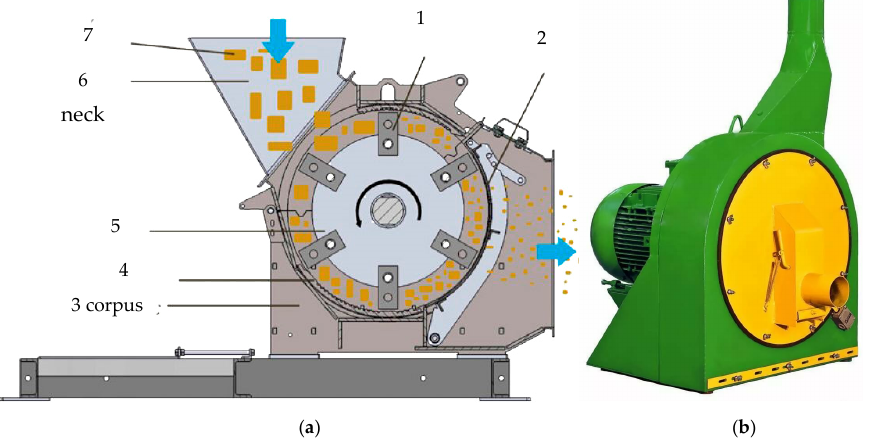
Figure 1. Grain hammer mill (own study): ( a ) section—view: 1—hammer, 2—sieve, 3—corpus, 4—deck, 5—rotor, 6—loading, 7—crushed raw materials; ( b ) housing—view.